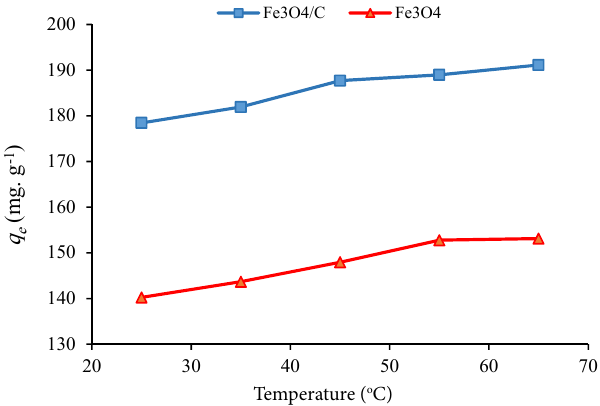
Fig. 12: Effect of temperature on dye adsorption (experimental conditions: dosage = 10 mg at pH =10, volume of solution = 30 mL, dye concentration = 70 mg. L -1 )